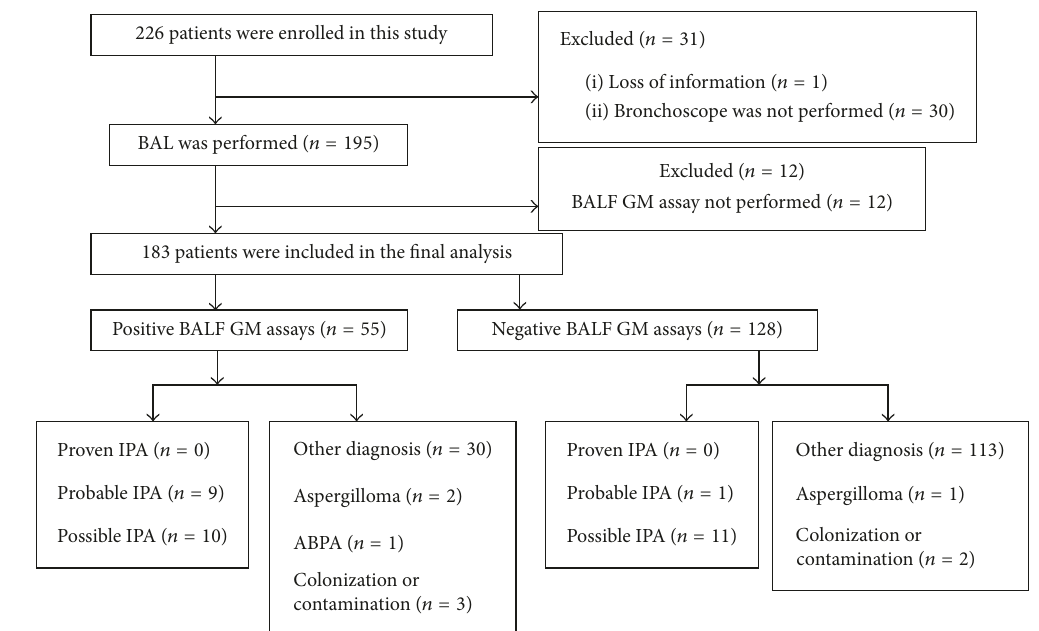
Figure 1: Study flow diagram. BAL, bronchoalveolar lavage; BALF, bronchoalveolar lavage fluid; GM, galactomannan; IPA, invasive pulmonary aspergillosis; ABPA, allergic bronchopulmonary aspergillosis.